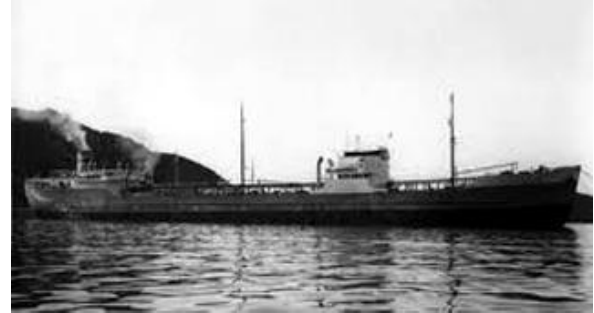
Figure 1: Río Miera cargo ship (source: sitepecios.com) On December 6, 1951; a small merchant called Mogador collided head on Río Miera and the cargo began to sink quickly. Cantabrian coast was the scene of many shipwrecks, and some of them remain without explore. Nowadays Río Miera is one of the reference points of immersion of the Cantabrian coast. The study area is located at 15 nautical miles from the coast in a sedimentary zone (Fig. 2).